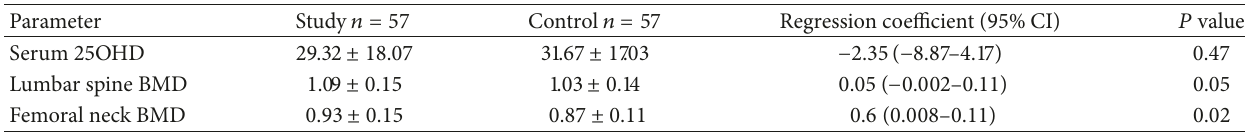
Table 2: Results of serum 25-hydroxyvitamin D, lumbar spine BMD, and femoral neck BMD in the study and control groups. CI: co nfidence interval; 25OHD: 25-hydroxyvitamin D; BMD: bone mineral density.